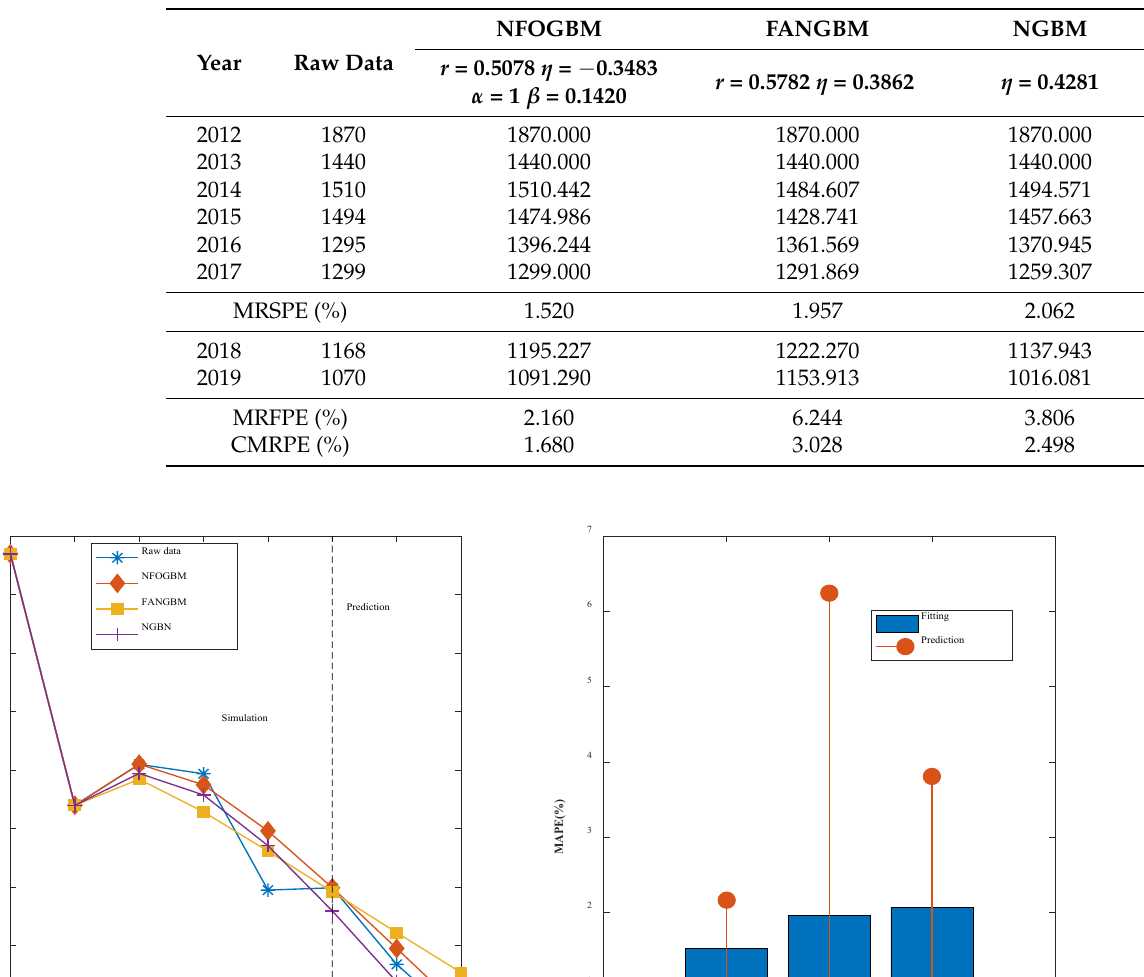
Table 4. Modeling results for TSPTS.